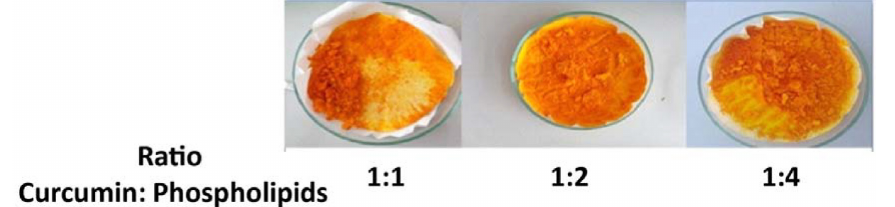
FIGURE 1 - Physical properties of curcumin phytosome at different ratios.